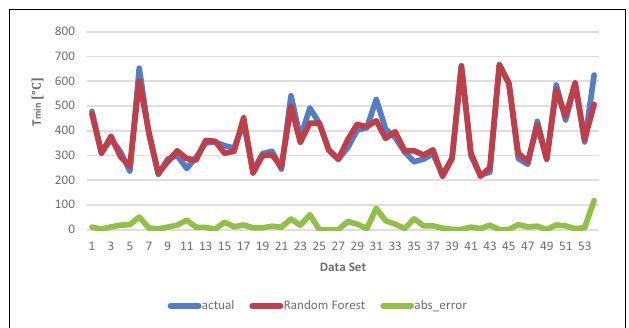
FIGURE 4 | Prediction vs. actual for the testing data sample (54 samples) set with absolute error plotted at the bottom of the graph.